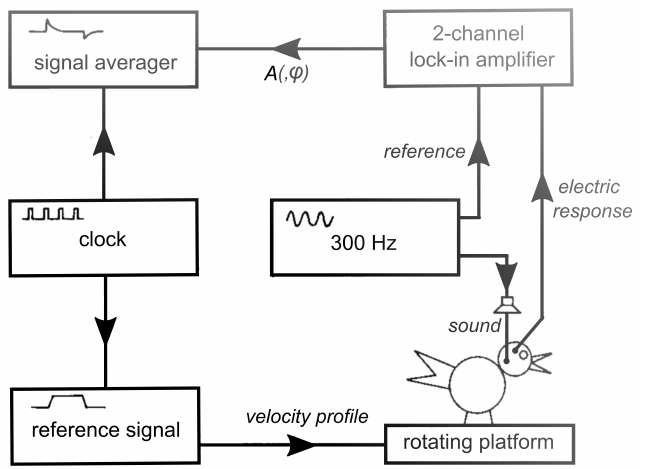
Figure 1. Schematic of stimulation and recording equipment. The clock synchronises signal averager and reference signal generator. The lock-in amplifier is used in the amplitude-phase (A, φ ) mode. (Modified from Reference